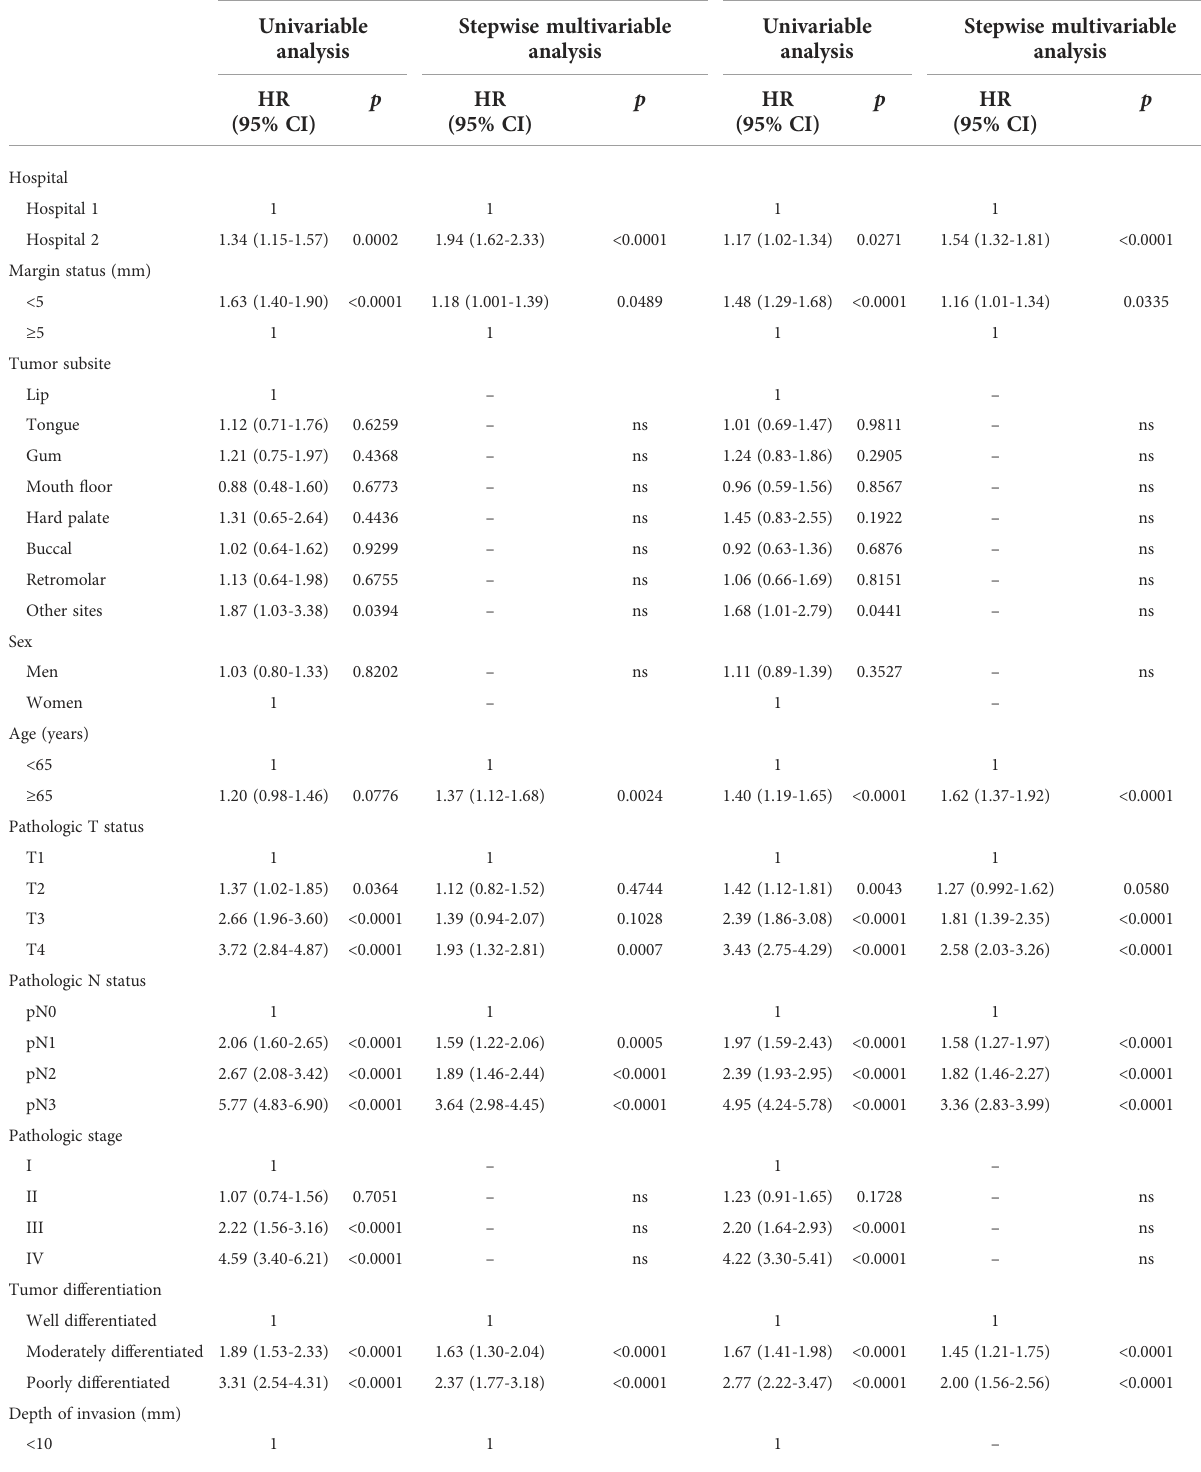
TABLE 3 Univariable and multivariable analyses of risk factors for 5-year disease-speci fi c and overall survival rates in patients with oral cavity squamous cell carcinoma (n = 3028) enrolled from Hospital 1 and Hospital